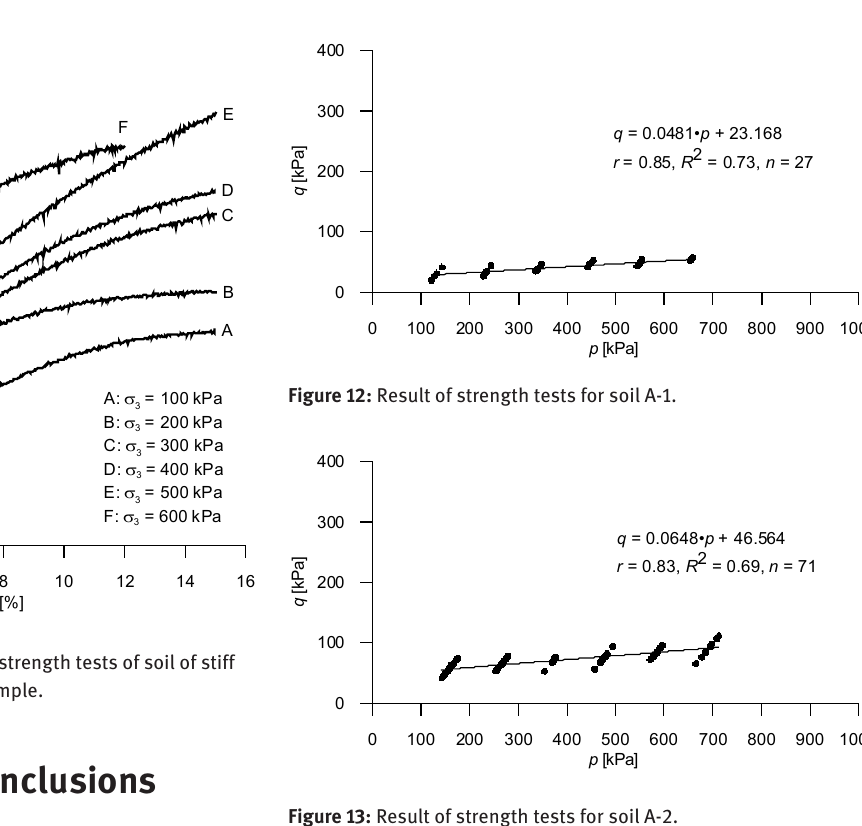
Figure 13: Result of strength tests for soil